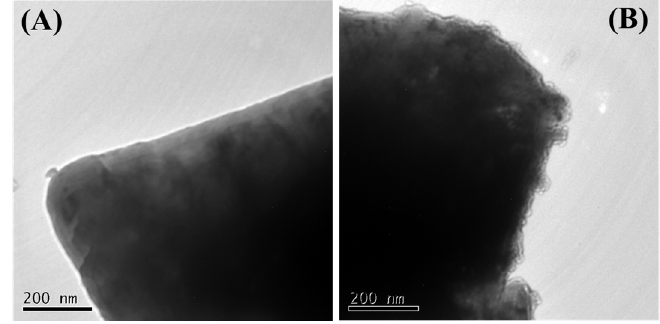
Figure 3. TEM (transmission electron microscopy) images of ( A ) TiSi 2 and ( B ) WS 2 ‐ 1/TiSi 2 ‐ 723.